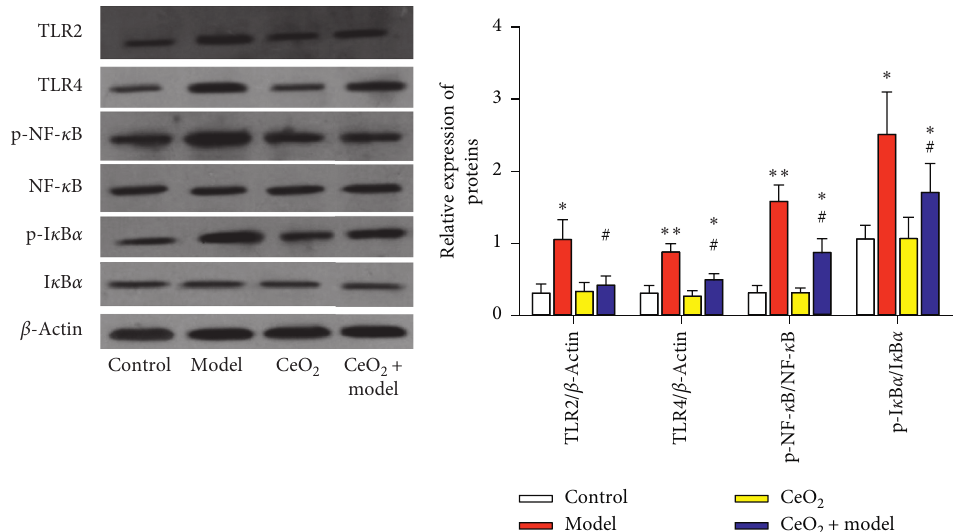
Figure 7: Changes of protein expression in peritoneal tissue of rats in each group. Compared with the control group, ∗ P < 0 . 05, ∗∗ P < 0 . 01; compared with the model group, # P < 0 .